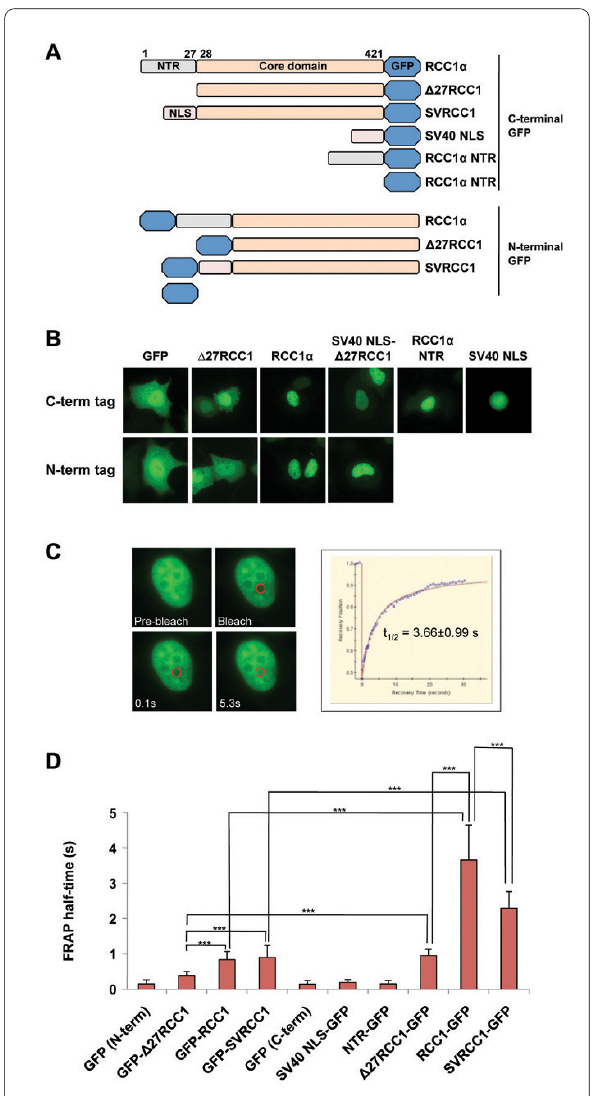
Figure 1 The N-terminal region (NTR) or tail of RCC1α is required for stable interaction with chromatin in live cells . (A) Schematic di- agrams of N-terminal and C-terminal GFP fusion constructs. (B) Repre- sentative images of live HeLa cells expressing the N-terminal and C- terminal GFP fusion constructs. (C) Fluorescence recovery after photo- bleaching (FRAP) of RCC1α-GFP. Images of a cell during the timecourse are shown (left). Circles indicate the region of photobleaching. Output of data (right) with FRAP half-time (t 1/2 ). (D) Mean of the FRAP t 1/2 for each GFP fusion construct. Data from 3 independent experiments were combined and tested for significant difference in FRAP t 1/2 using the one-way ANOVA test. P-value less than 0.05 was considered to be statistically different (p-value < 0.001 shows as